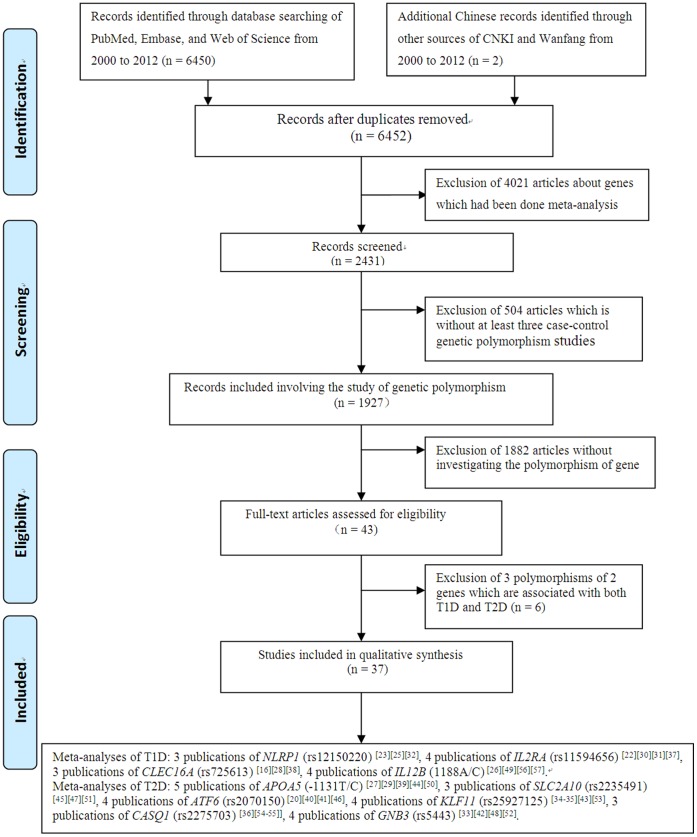
Flow diagram of selecting studies for meta-analysis.